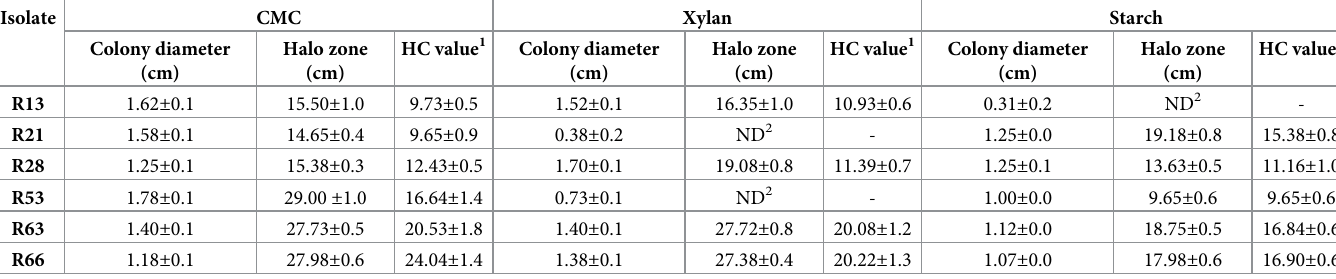
Hydrolytic capacities of six bacterial isolates were calculated from ratio of halo zone over colony diameter. The assay was carried out in duplicate with three independent experiments. ± represents standard error of mean.